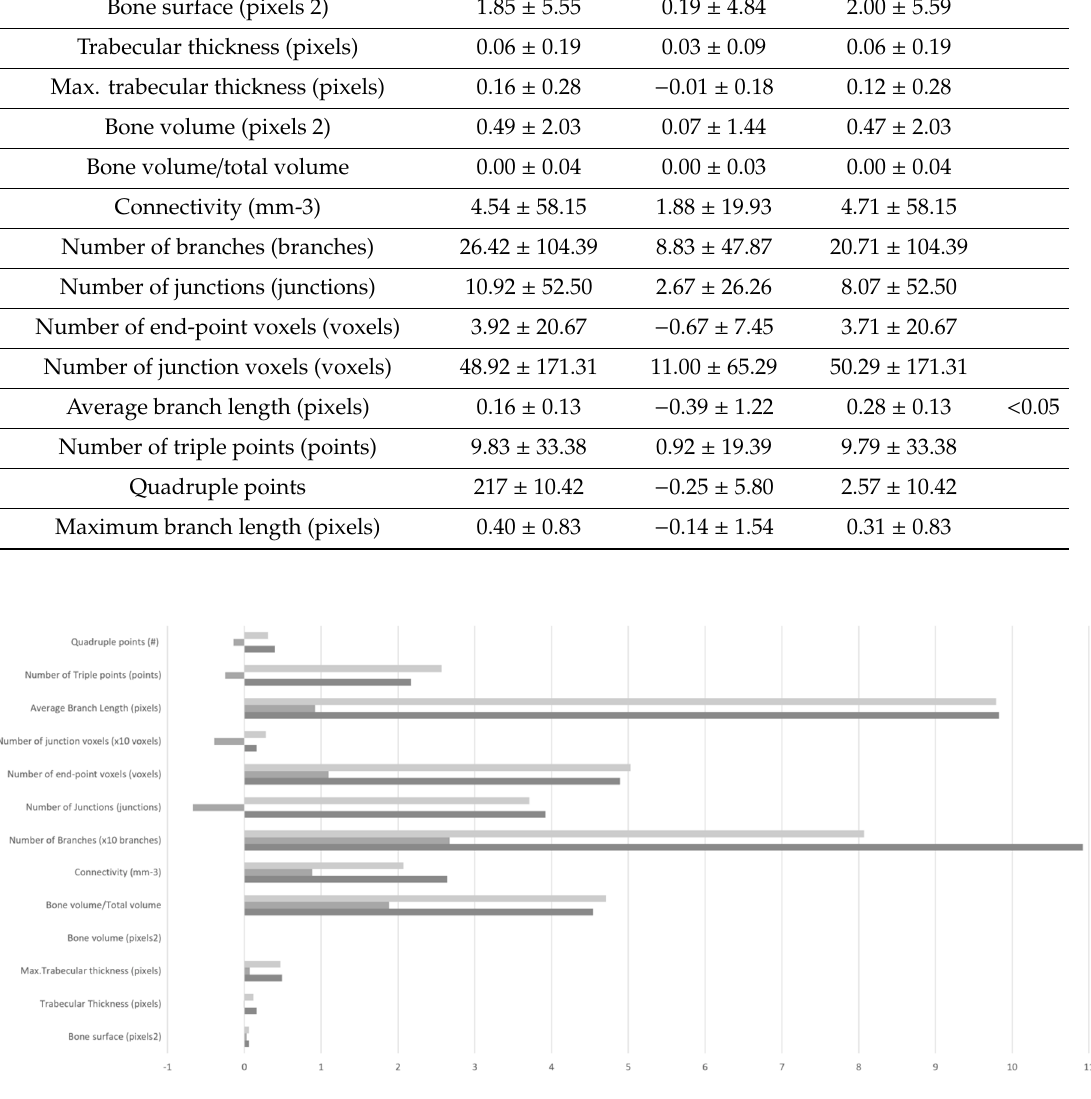
Table 3. Comparison of Bone Density (BoneJ).